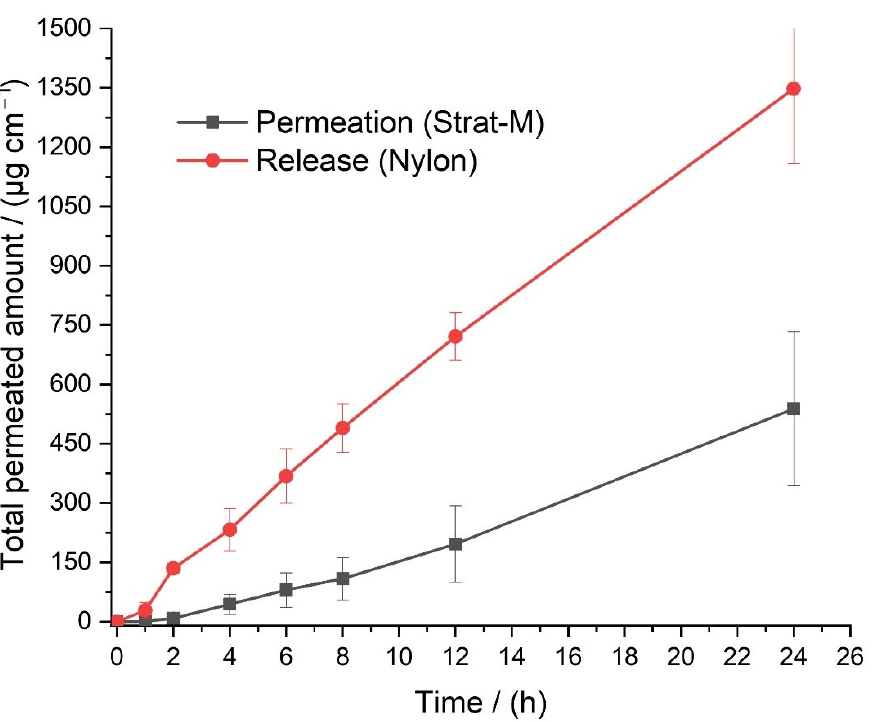
Figure 5. Permeation of THQ:HPβCD through Strat-M compared with release through a Nylon membrane ( n = 4), error bar= standard error (SE).